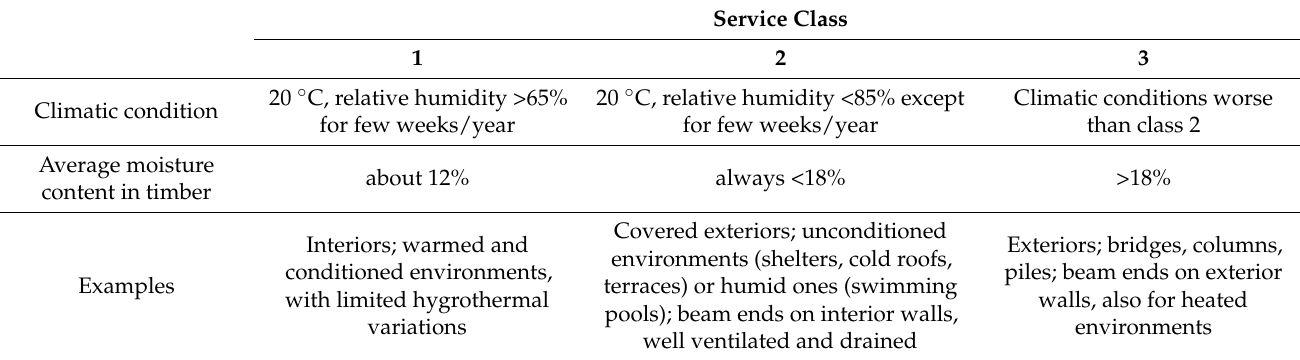
Table 1. Service classes for timber structures and typical